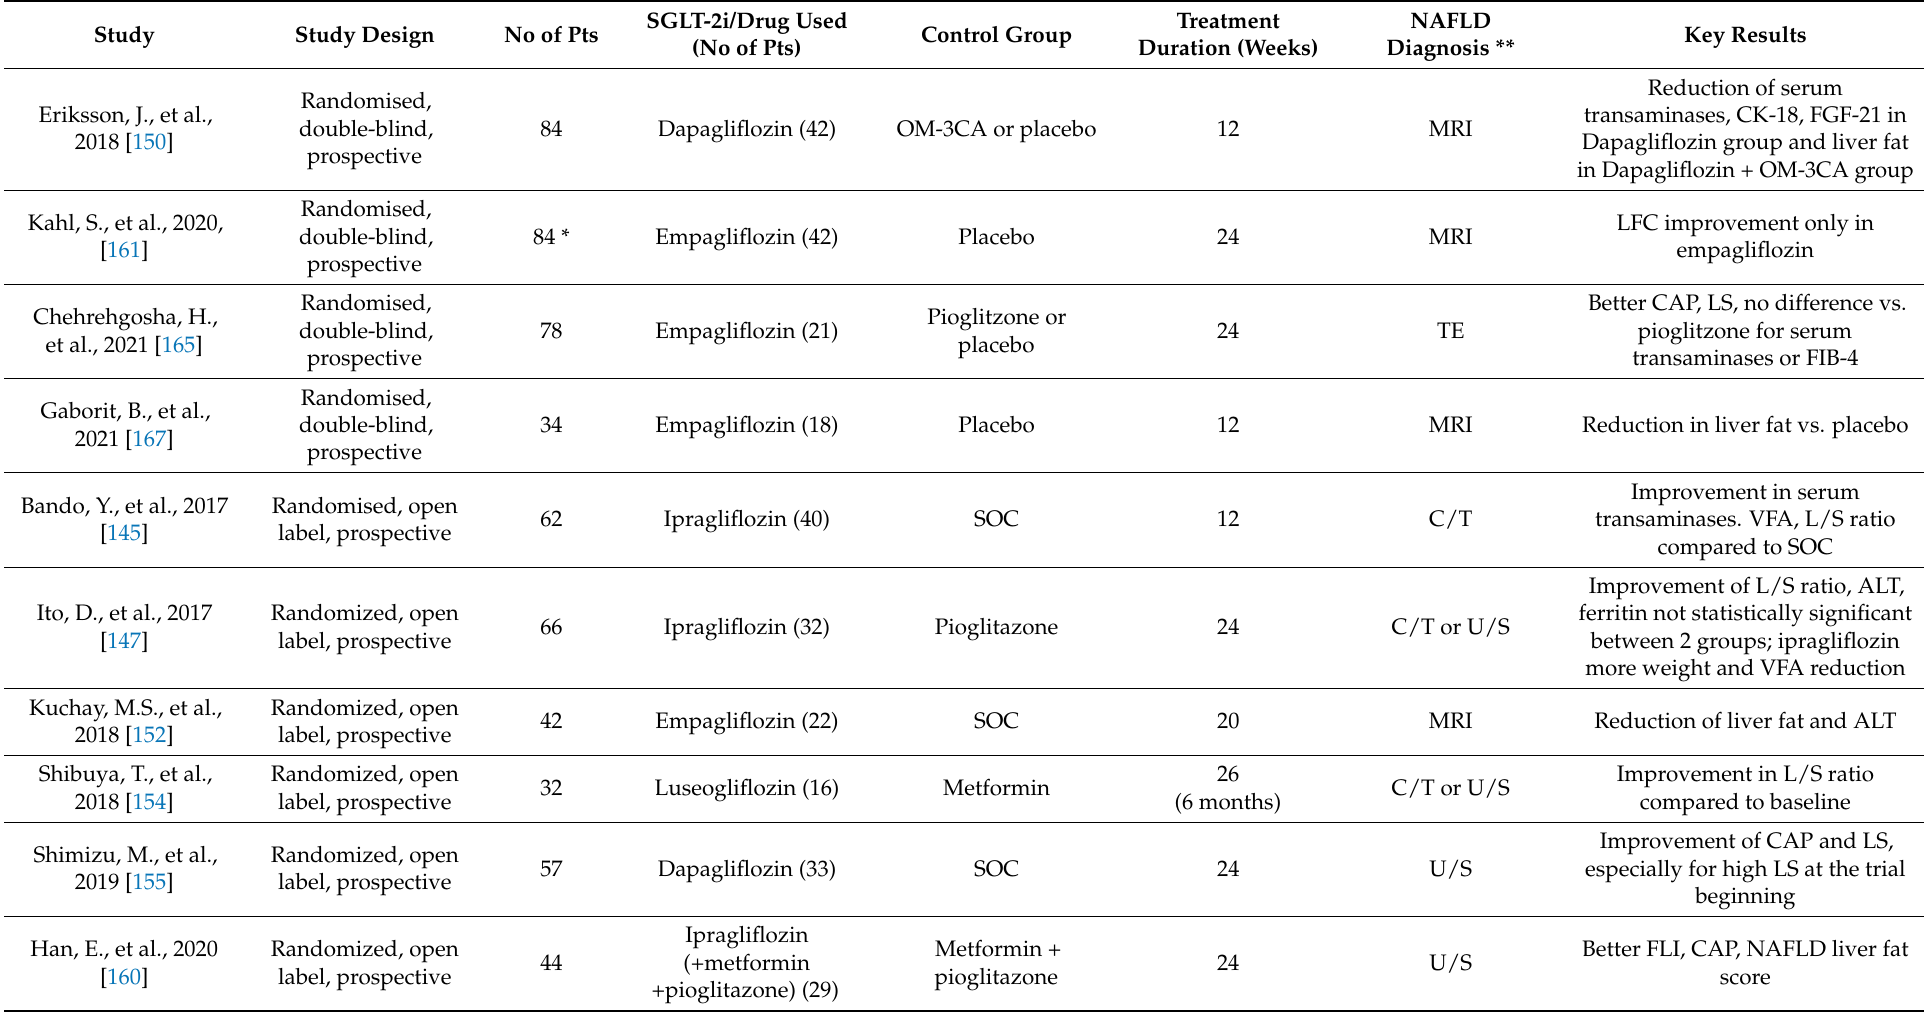
Table 5. Studies on the impact of SGLT-2i on NAFLD in patients with